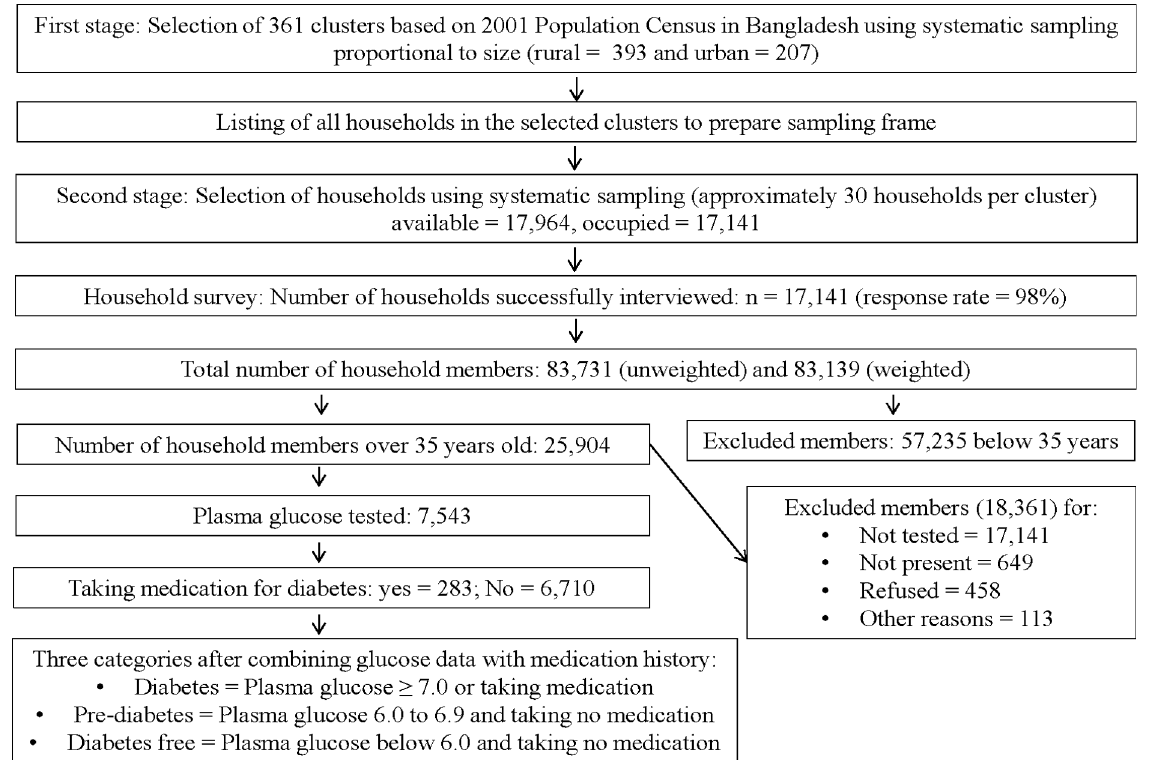
Figure 1. Sampling strategy and study population.